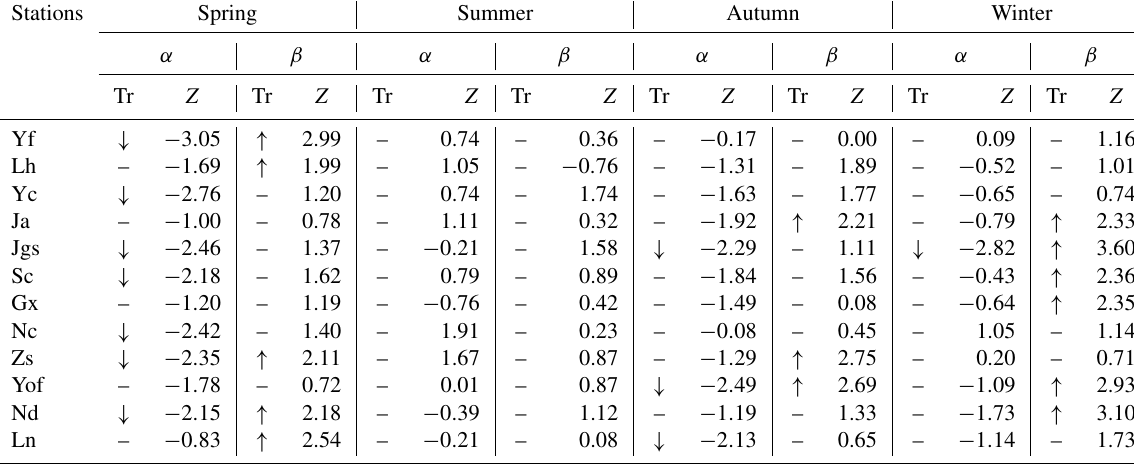
Table 4. Changes of the gamma distribution parameters α and β in each station and season during 1959 to 2016. Z : Z values from the M–K test. When Z is bigger than 0, the trend is upward; when Z is smaller than 0, the trend is downward. When the absolute value of Z is bigger than or equal to 1.28, 1.64 and 2.32, it means that the test has passed the reliability test of 90%, 95% and 99%, respectively. Tr: trend of α and β . Increasing ( ↑ ): when the M–K statistic is positive and the confidence level is below 0.05. Decreasing ( ↓ ): when the Mann–Kendall statistic is negative and the confidence level is below 0.05. No trend (–): there is no trend detected according to the confidence level.